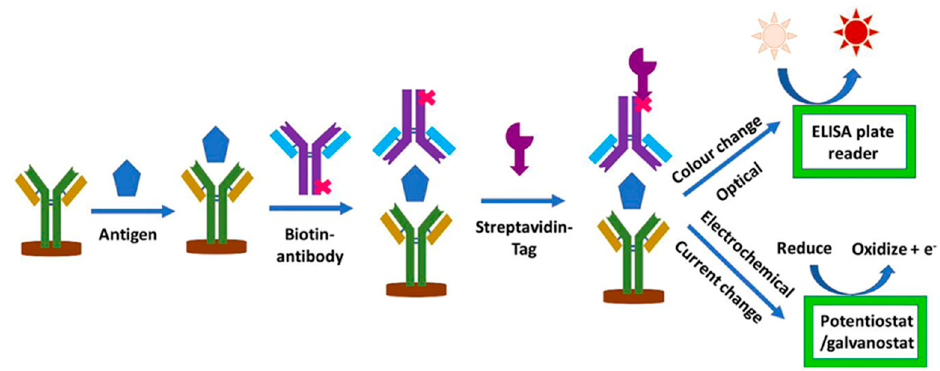
Figure 7. General scheme of the analysis by ELISA. Reused from [83]. Copyright 2018, MDPI AG.